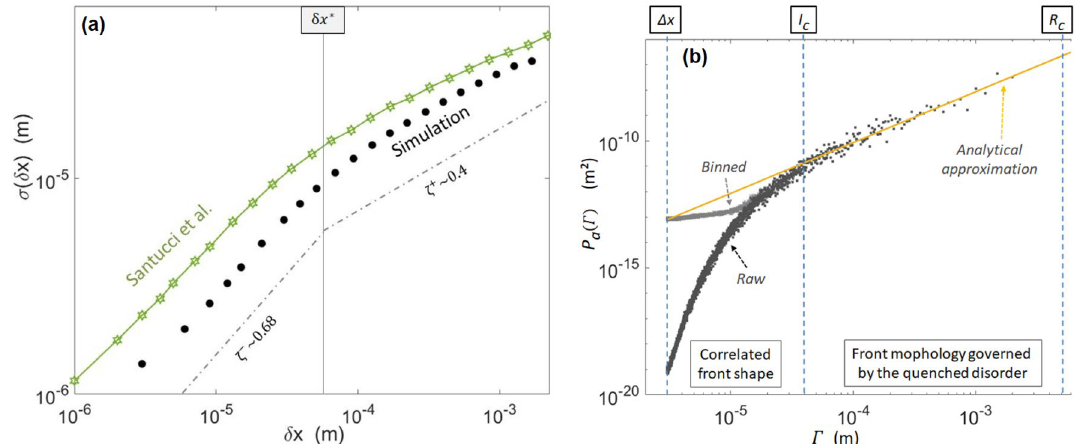
Figure 11. ( a ) Advancement fluctuation σ along the crack fronts, as per Eq. (15), for the simulation (plain points) and an experimental data set from Santucci et al. 27 (see their Fig. 4). Different self-affine behaviours are observed above and below the δ x ∗ cut-off, with comparable Hurst exponents ζ . The dashed lines mark the slopes fitted on the simulation data for the two cases. The experimental points are from an experiment different from those of Tallakstad et al. 28 to which the model was calibrated. ( b ) Power spectra of the simulated crack advancement, averaged over 10,000 consecutive fronts. It is shown both before (raw) and after (binned) binning the fronts to the experimental camera pixel size. The difference between these two plots shows an influence of the observation scale on the small-scale study of the crack morphology. The plain line is the approximation 8 from Eq. (18), which is valid between l c and R c , where the morphology is dominated by the material quenched disorder. Note that the scaling regime for scales above l c was already studied by Cochard et al. 8 , while the model match to the experiment below this cut-off scale, shown in ( a ), is a new result, as already discussed in the “Local velocity distribution and fracture energy standard deviation”